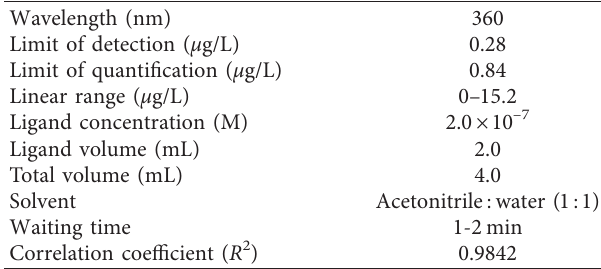
2+ ] to determine the 0 /(I 0 -I) versus 1/[Cu